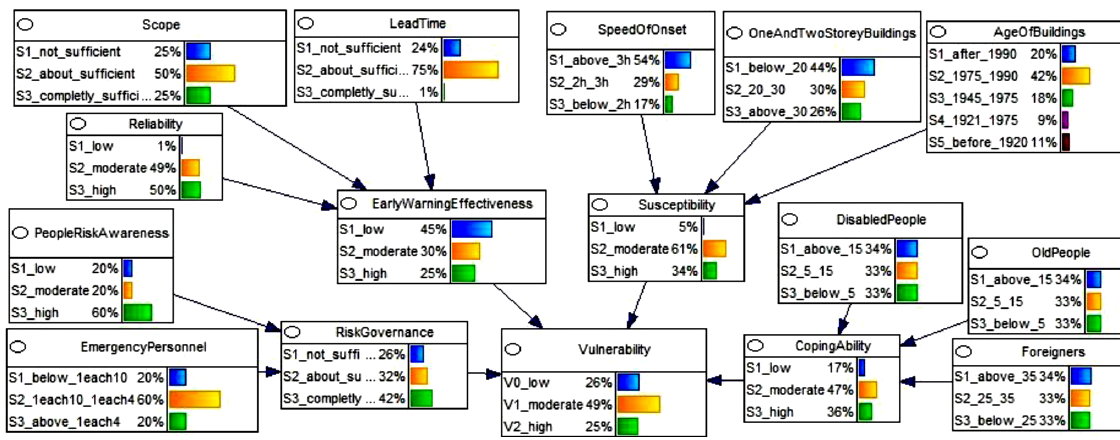
Figure 4. Vulnerability Bayesian network and summarized sensitivity.